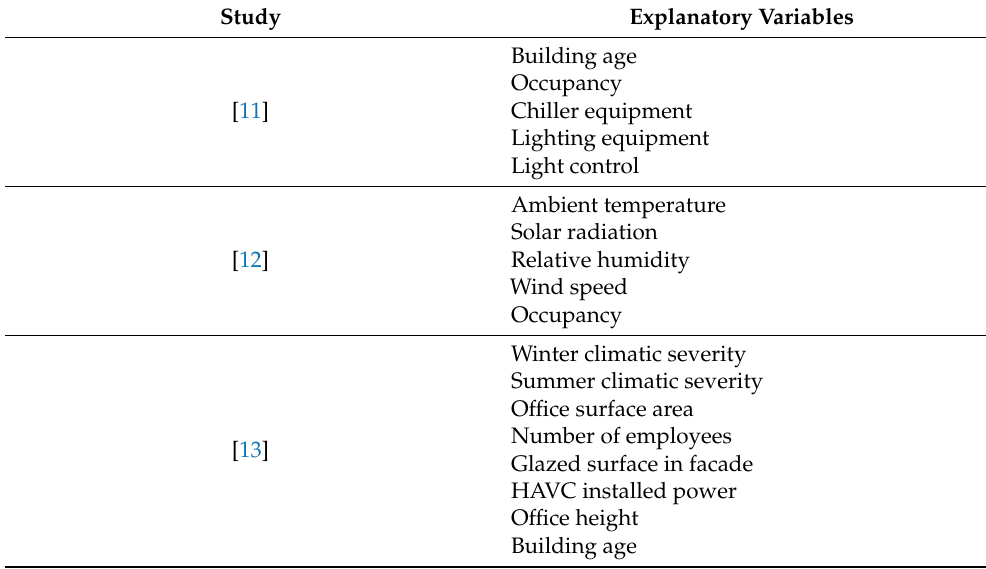
Table 1. Summarization of explanatory